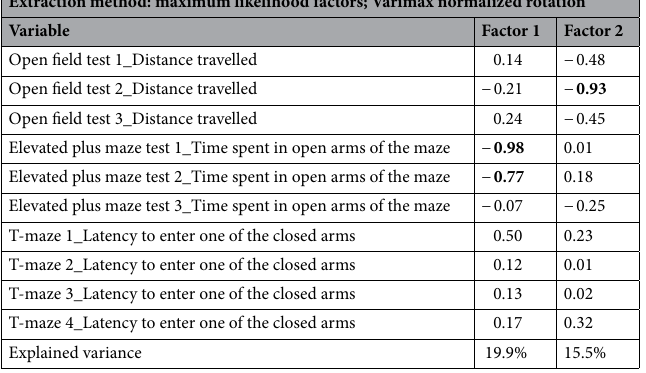
Factor analysis of personality tests Extraction method: maximum likelihood factors; Varimax normalized